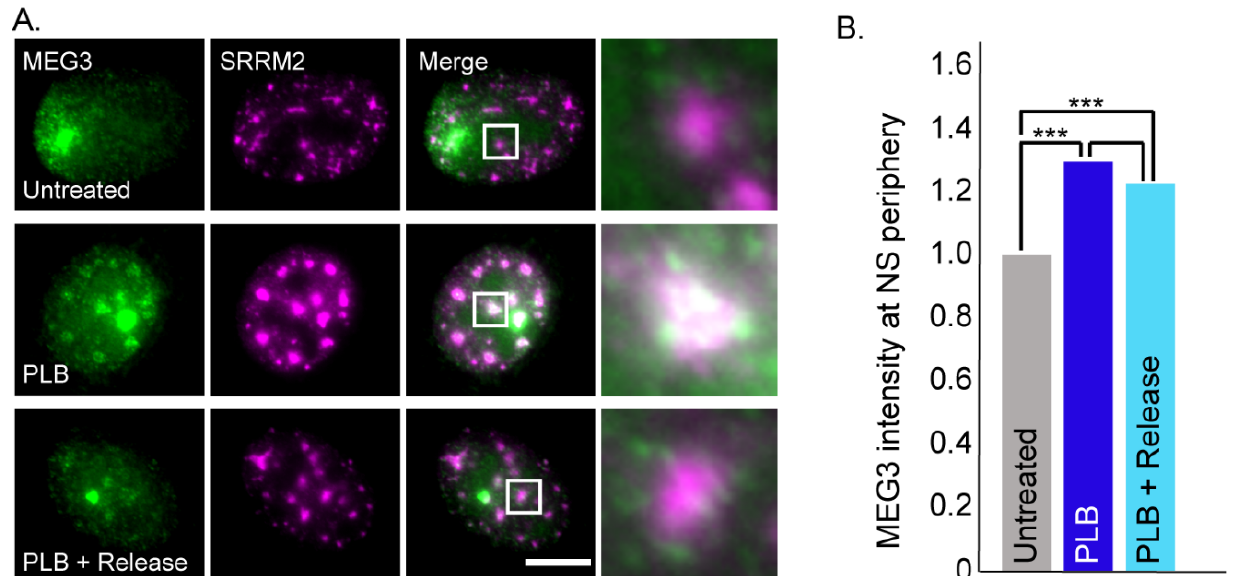
Figure 5. MEG3 surrounds nuclear speckles in response to splicing inhibition. ( A ) RNA FISH of MEG3-MS2 transcripts (green) and antibody staining of SRRM2 in nuclear speckles (purple). (Top) Untreated control cells, (middle) cells treated with PLB for 6 h and (bottom) cells treated with PLB for 6 h and then released 30 min before fixation. Bar = 10 µ m. Enlargements of the boxed areas are on the right. ( B ) Plot demonstrating the changes in MEG3 association with nuclear speckles (NS) under untreated conditions (#cells = 84, #NS = 1057), PLB treatment (#cells = 111, #NS = 1212) and after a 30 min release from PLB (#cells = 116, #NS = 1403) ( t -test, *** p < 0.0001).